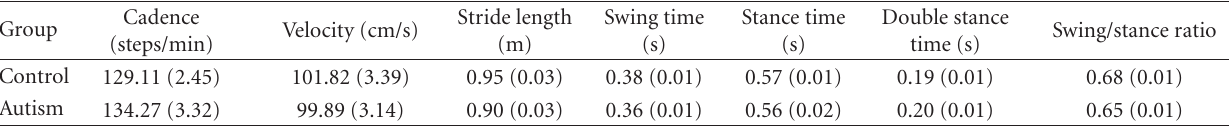
Table 2: Descriptive statistics (mean and standard error) for temporal-spatial data for the autism and age-matched control group.